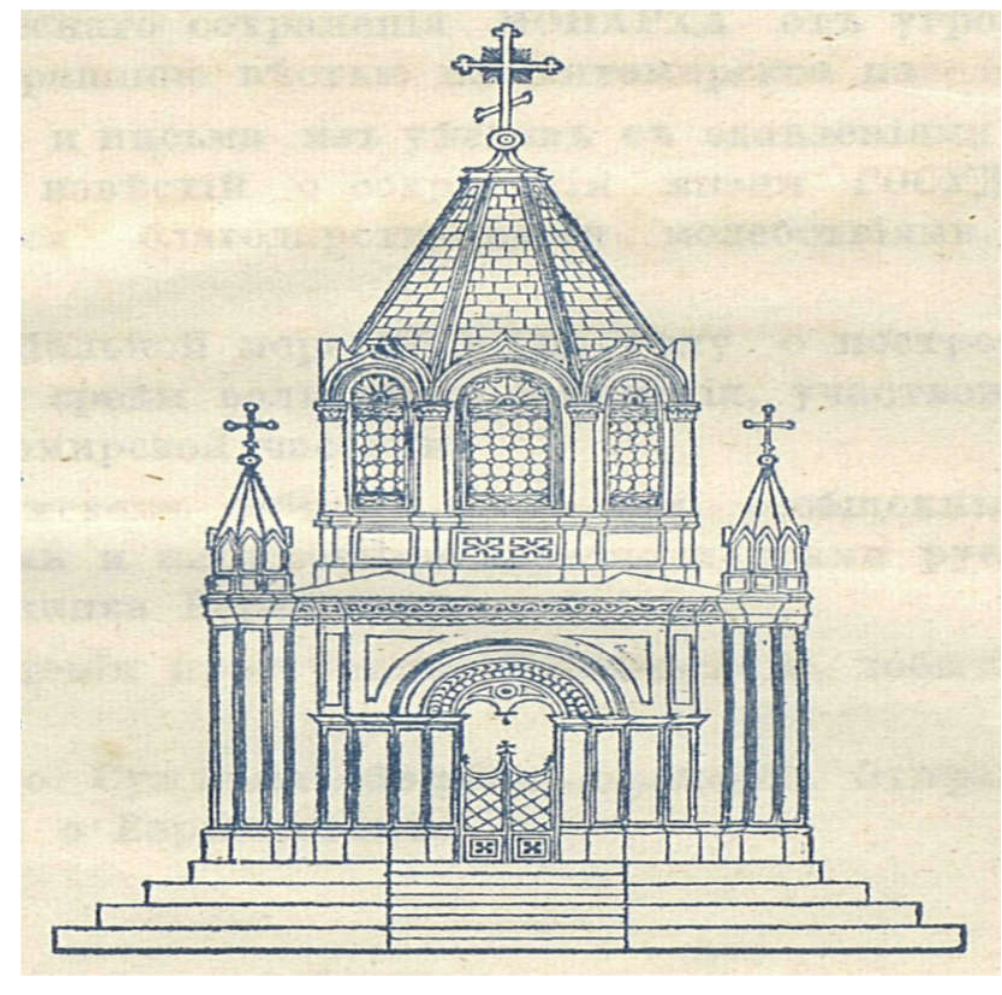
Figure 5. Source: Bratchikov (1868, p. 2).